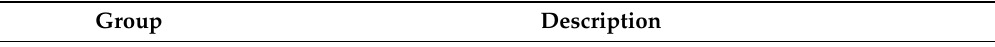
Table 1. Study groups and types of the prostheses used.